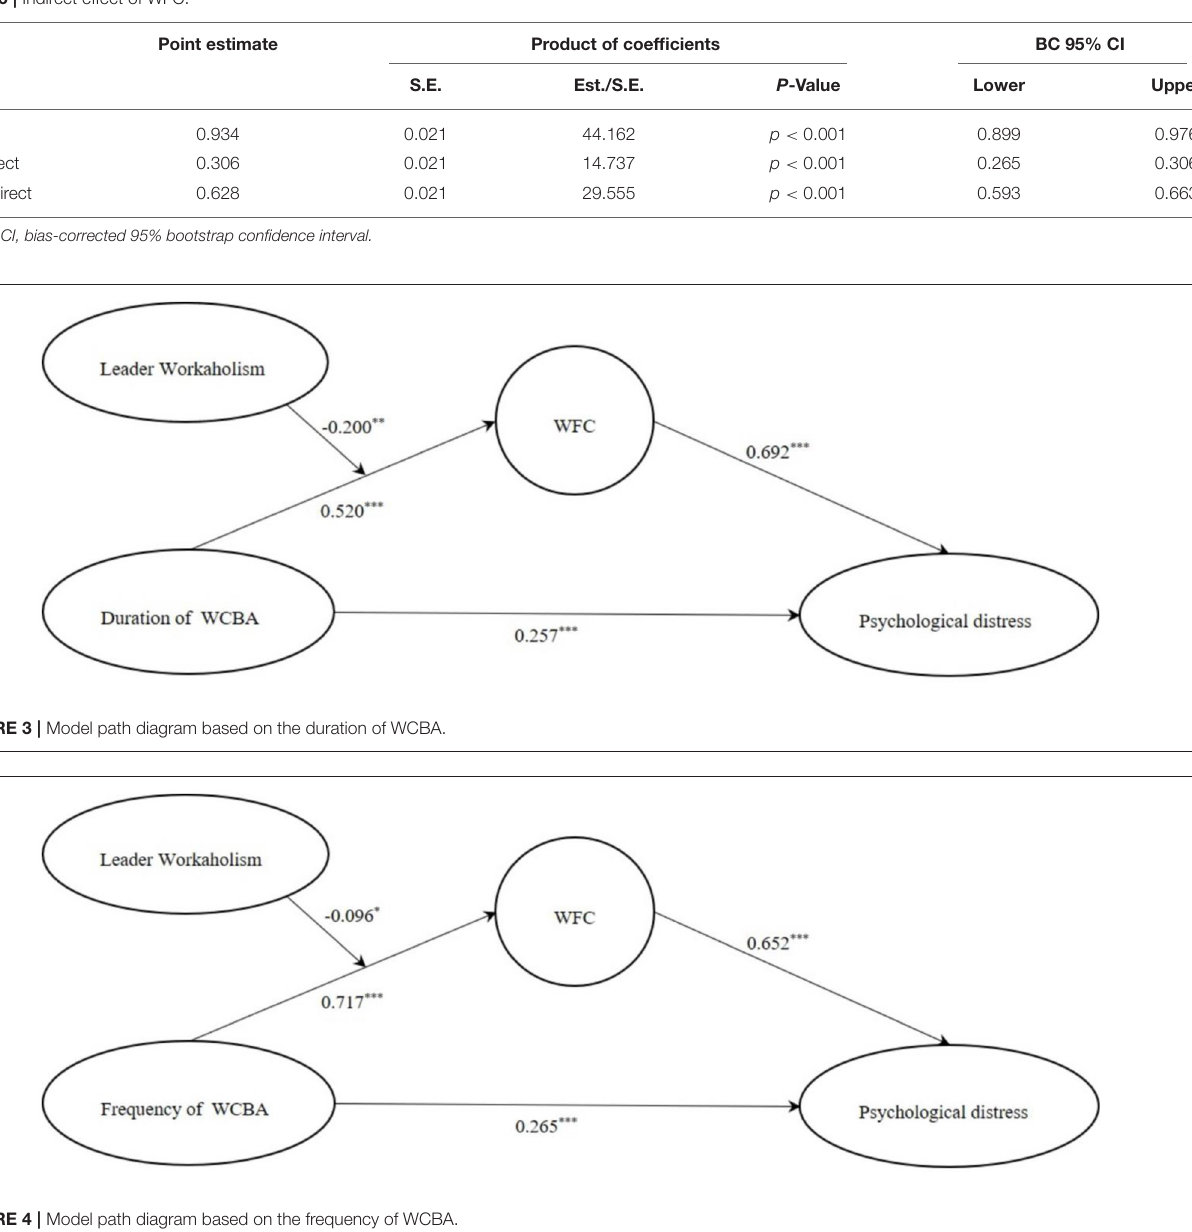
FIGURE 4 | Model path diagram based on the frequency of